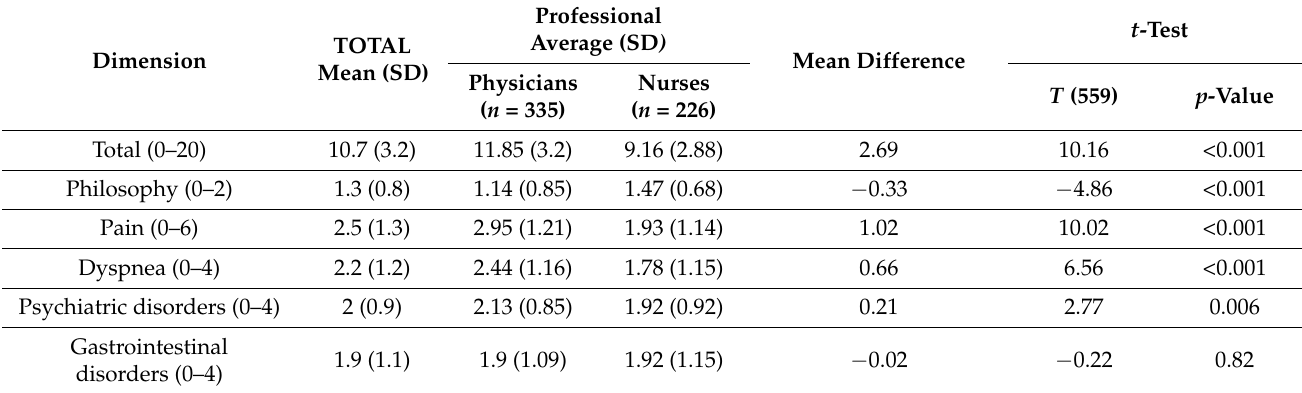
Table 2. Score description of PCKT-SV for physicians and